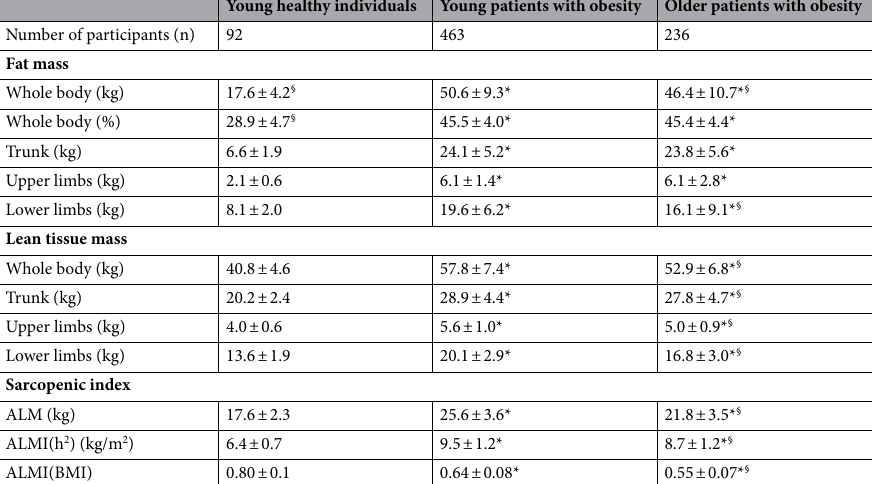
Table 2. Whole body, truncal and appendicular fat mass and lean tissue mass in women regarding age group and obesity status. Data are presented as the mean ± SD. Body mass index for young healthy controls ranged from 18 kg/m 2 ≤ BMI ≤ 25 kg/m 2 and was > 30 kg/m 2 in patients with obesity. ALM appendicular lean mass; ALMI appendicular lean mass index [ALMI(h 2 ): ALM/height 2 and ALMI(BMI): ALM/BMI)]; BMI body mass difference compared to 18–35 women with obesity